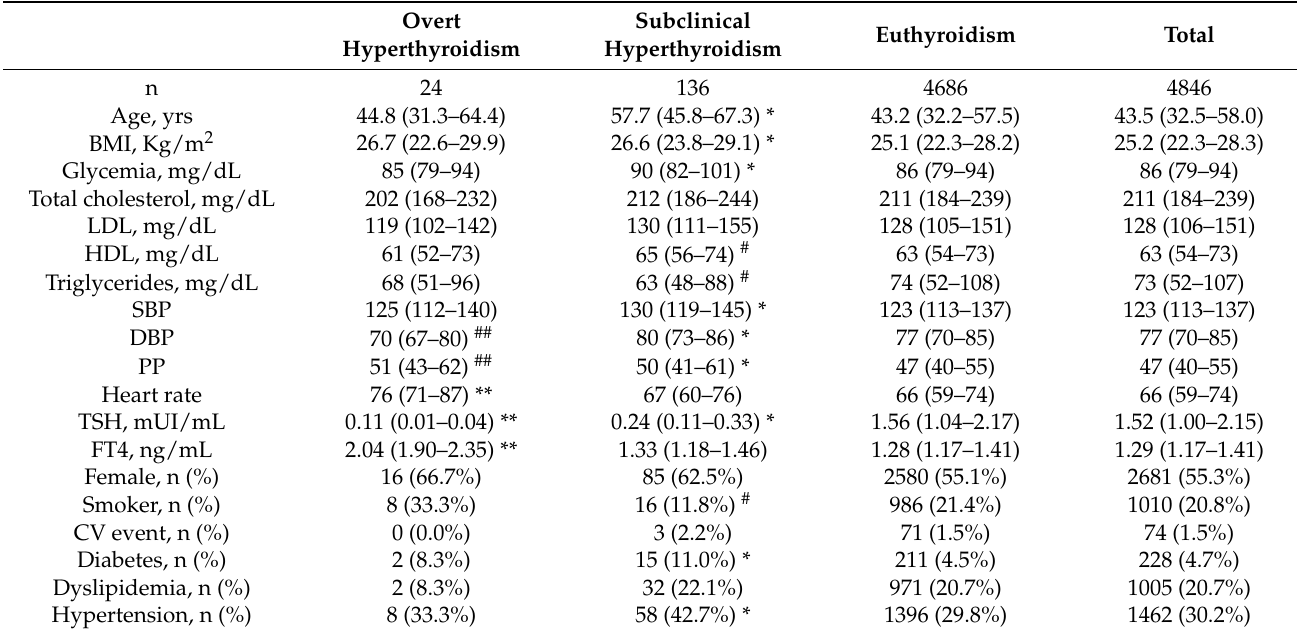
Table 1. Descriptive characteristics of the sample.